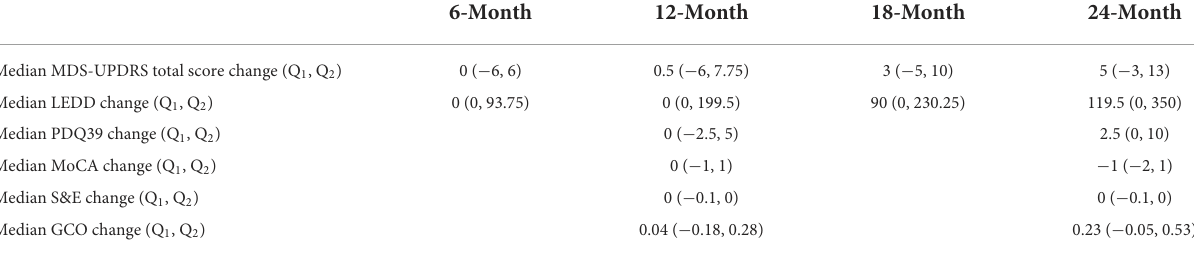
TABLE 2 Median change in each outcome variable by timepoint specified (units per